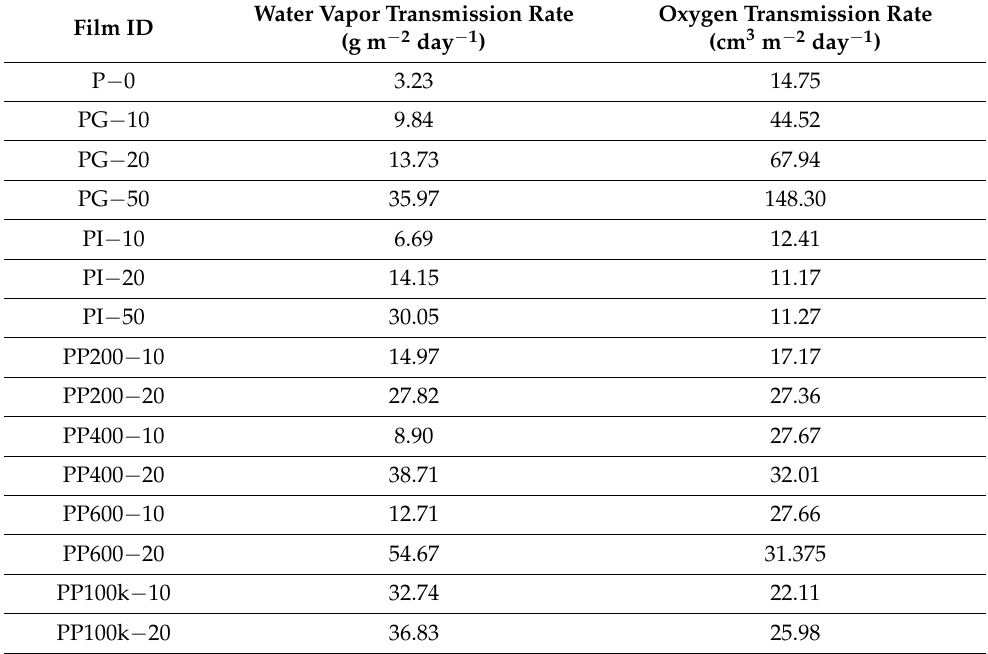
Table 5. Water vapor and oxygen transmission rates of PHBH